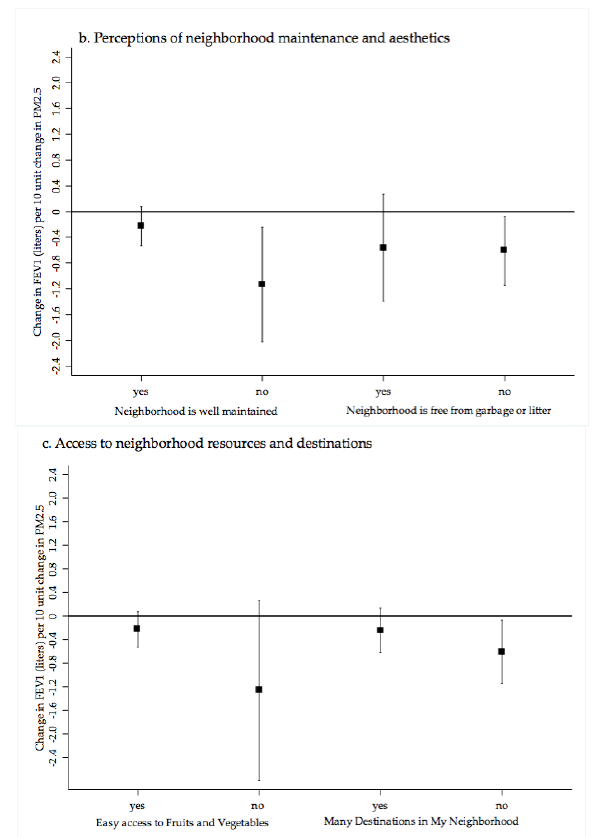
Figure 2. Association between Three-Year Annual Average PM 2.5 stratified by Neighborhood Stressors ( a ) perceived safety from crime for walking or biking and experience of stress from neighborhood in last 12 months. ( b ) Neighborhood maintenance and aesthetics (free of broken garbage and litter). ( c ) Limited access to resources (fruits and vegetables) and lack of destinations.